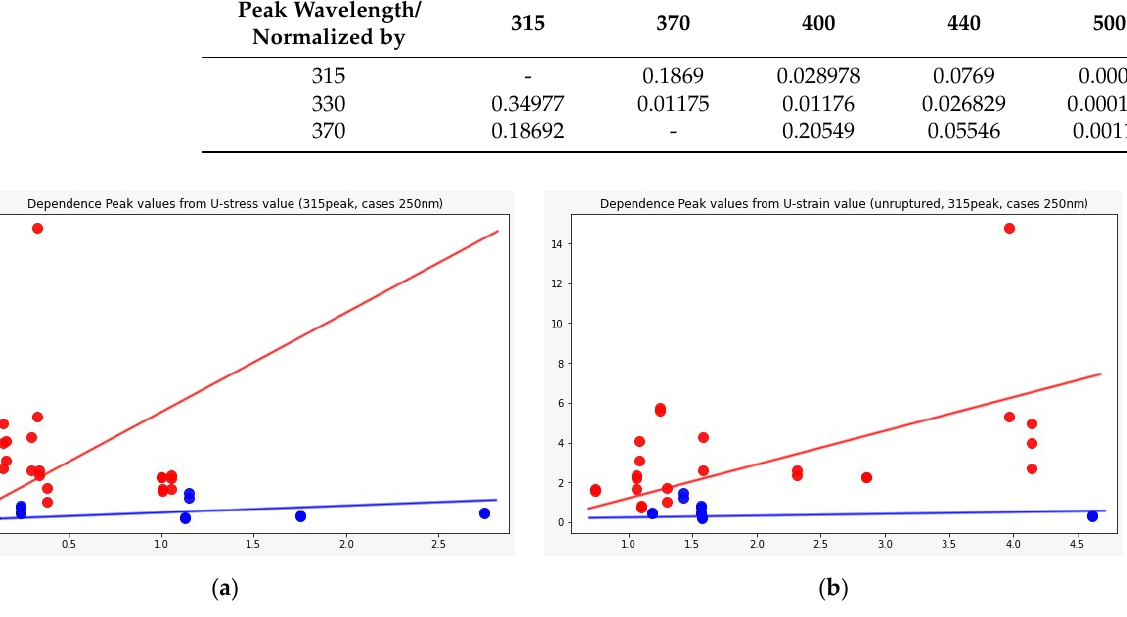
Figure 8. Dependence of the 315 nm peak component value from: ultimate stress ( a ) and ultimate strain ( b ); Red dots: ruptured cases, blue: unruptured. Regression analysis was performed, which showed the best result for the 250 radiation wavelength, 315 peak component, where linear regression, in this case, is 48% more preferable than using mean values ( p -value = 0.01).